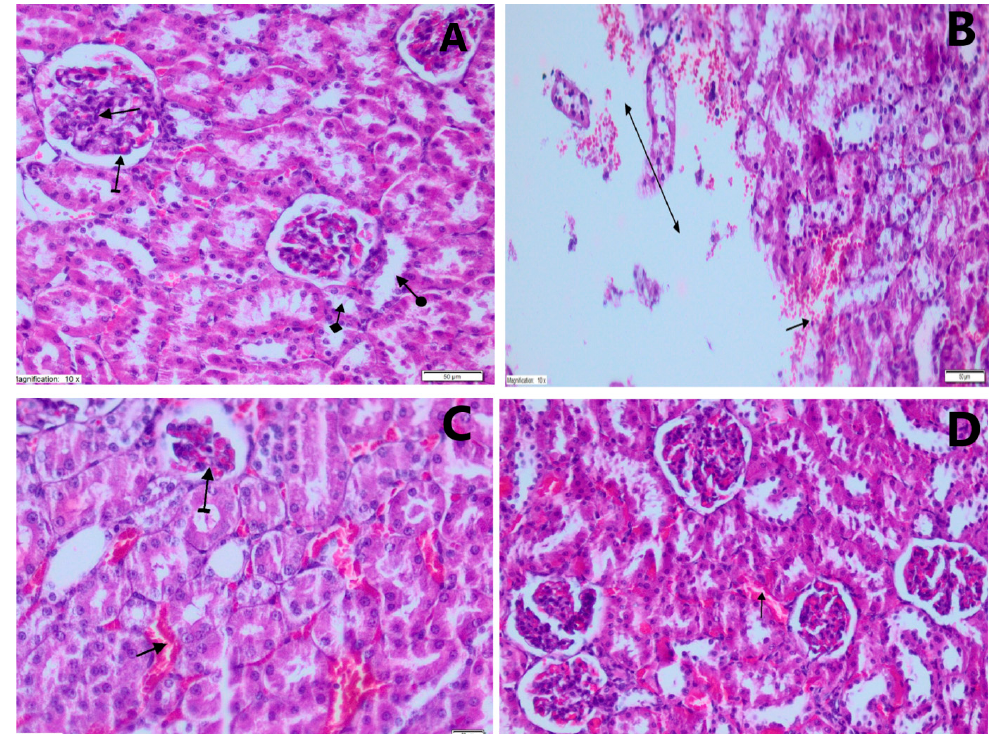
Figure 1. Results of the histopathological analysis. ( A ) Histological status in the control group (CG) animals, without any signs of kidney damage (H&EX200): glomerular structure (straight arrow), bowman capsule (straight arrow), proximal tubule (check arrow) and distal tubule (round arrow). ( B ) Histopathological changes of damaged kidney tissue in the paracetamol group (PARG) (H&EX200): hemorrhage in the parenchyma (straight arrow), destruction and edema (double-sided arrow). ( C ) Histopathological appearance of damaged kidney tissue in the PARG (H&EX200): mild atrophic glomerulus (striated arrow), dilated and congested blood vessels (straight arrow). ( D ) Histopathological changes (H&EX200) in the kidneys of animals treated with Taxifolin after administration of high dose PAR (TXFG): mildly dilated and congested blood vessels (straight arrow). Serum creatine increase was associated with the severity of glomerular damage (PARG: p = 0.015; TXFG: p = 0.022). On the other hand, only in the PARG was the MDA increase associated both with the extent of parenchyma destruction and edema ( p = 0.01) and glomerular damage ( p = 0.02). Hyperemia in the PARG animals was nearly significantly associated with the decreased GSH levels ( p =